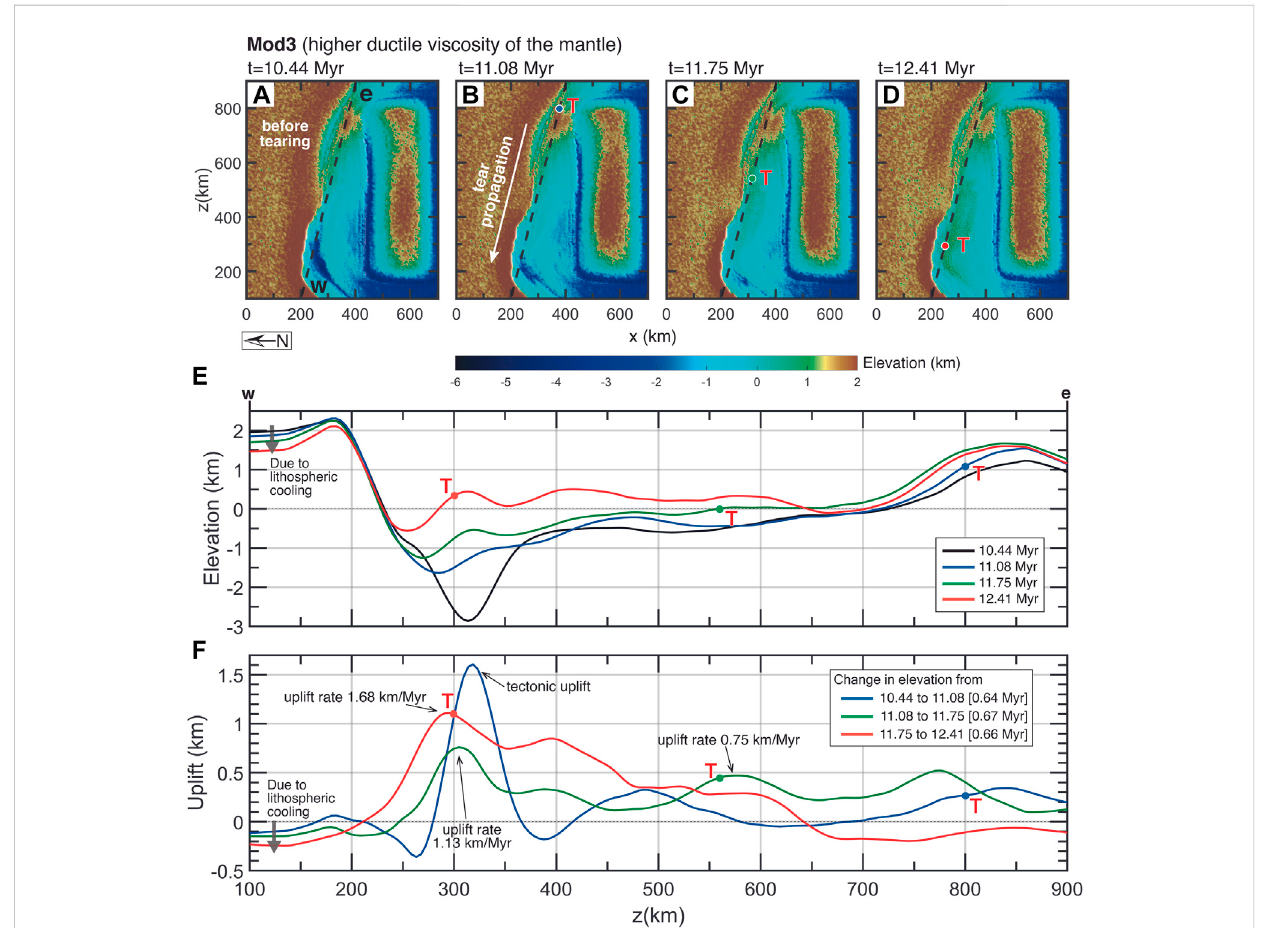
FIGURE 8 Elevation evolution of model Mod3 (higher mantle ductile viscosity). (A) , (B) , (C) , and (D) are map views of the model ’ s surface elevation evolution with the tear propagating westward. The red ‘ T ’ indicates the slab-tear position in the subsurface. The dash lines (W – E) in (A) through (D) represent the elevationpro fi lesshowninplot (E) .Plot (F) showstheamountofupliftbetweentimestepsasthetearingpropagateswestward.Theelevationincreasesas the tear propagates, with the maximum uplift rate of 1.68 km/Myr in the west. As the tear moves westward, the region toward the east of the pro fi le W-E starts to subside, as shown with the red line in plot (E)